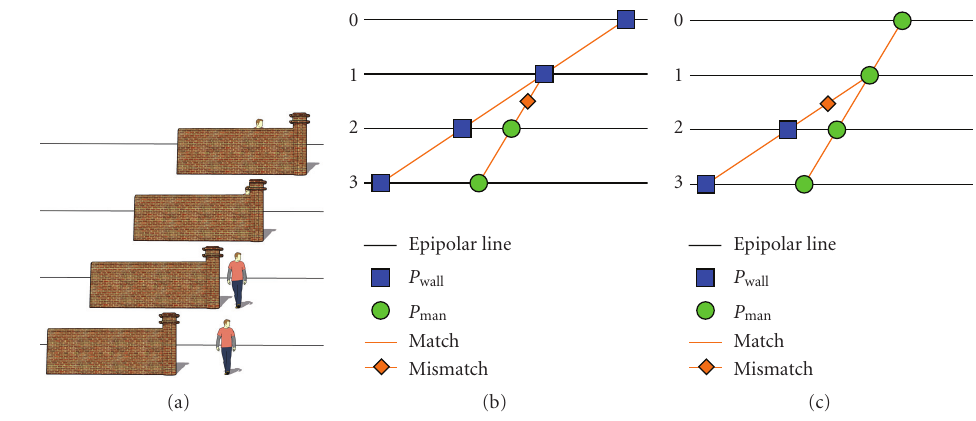
Figure 2: Examples of matching graphs.